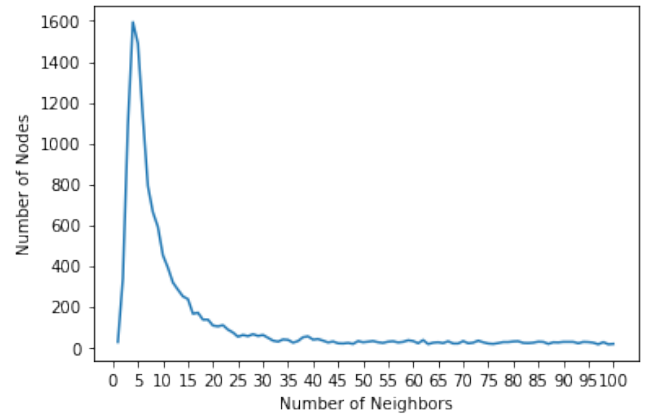
Figure 8. Nodes degree distribution in H2O network.